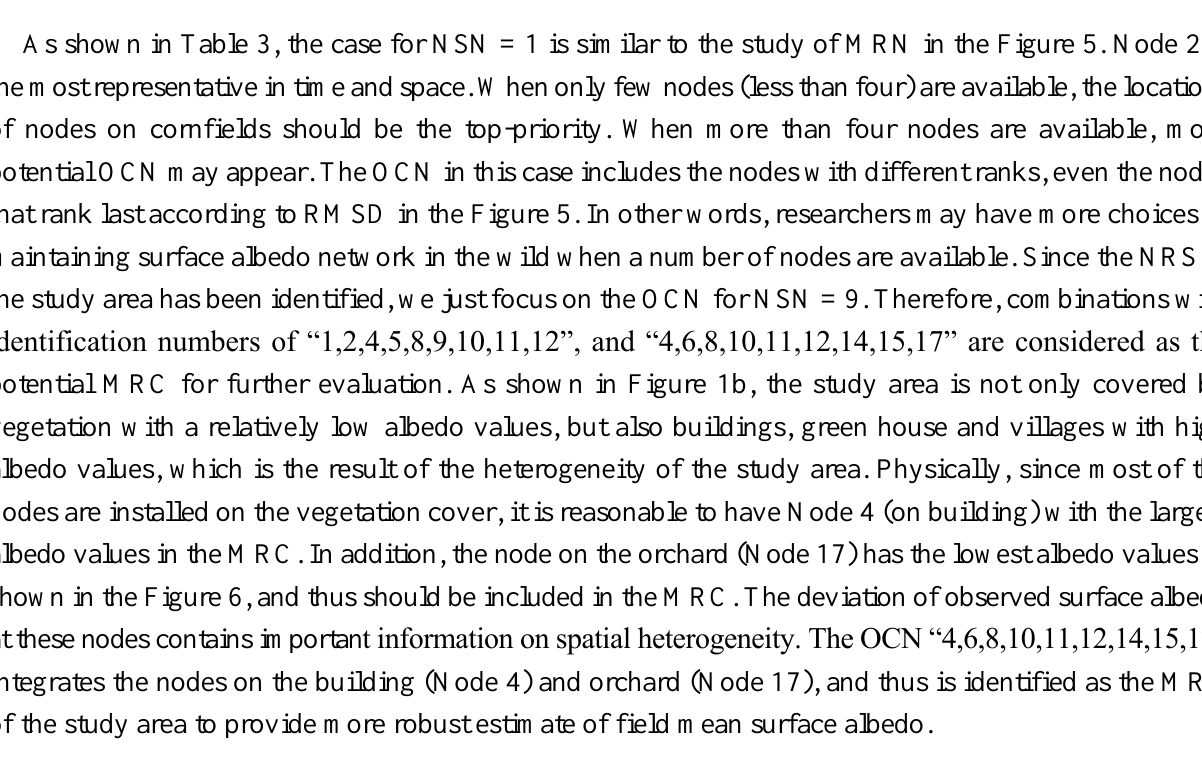
Figure 10. Frequency distribution histogram of number of sampled subsets and the cumulative frequency for Euclidean when NSN ranging from 6 to 10. ( a – e ) are the results when NSN are 6, 7, 8, 9, 10,